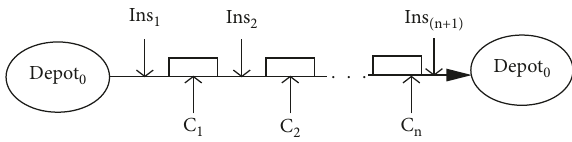
Figure 2: The generation process of the initial